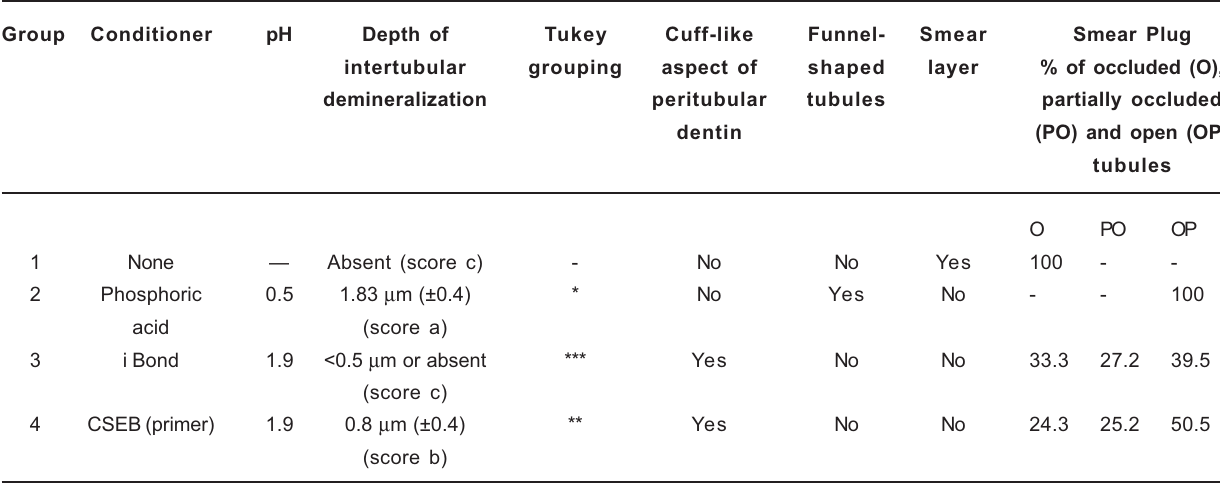
TABLE 2- Results according to the evaluated